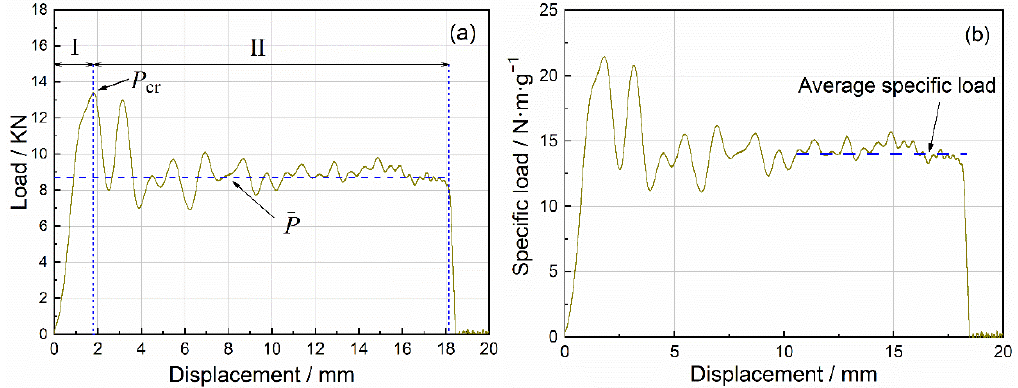
Figure 7. Typical impact curve for closed-cell Al foam ( a ) load–displacement curve ( b ) specific load–displacement curve.